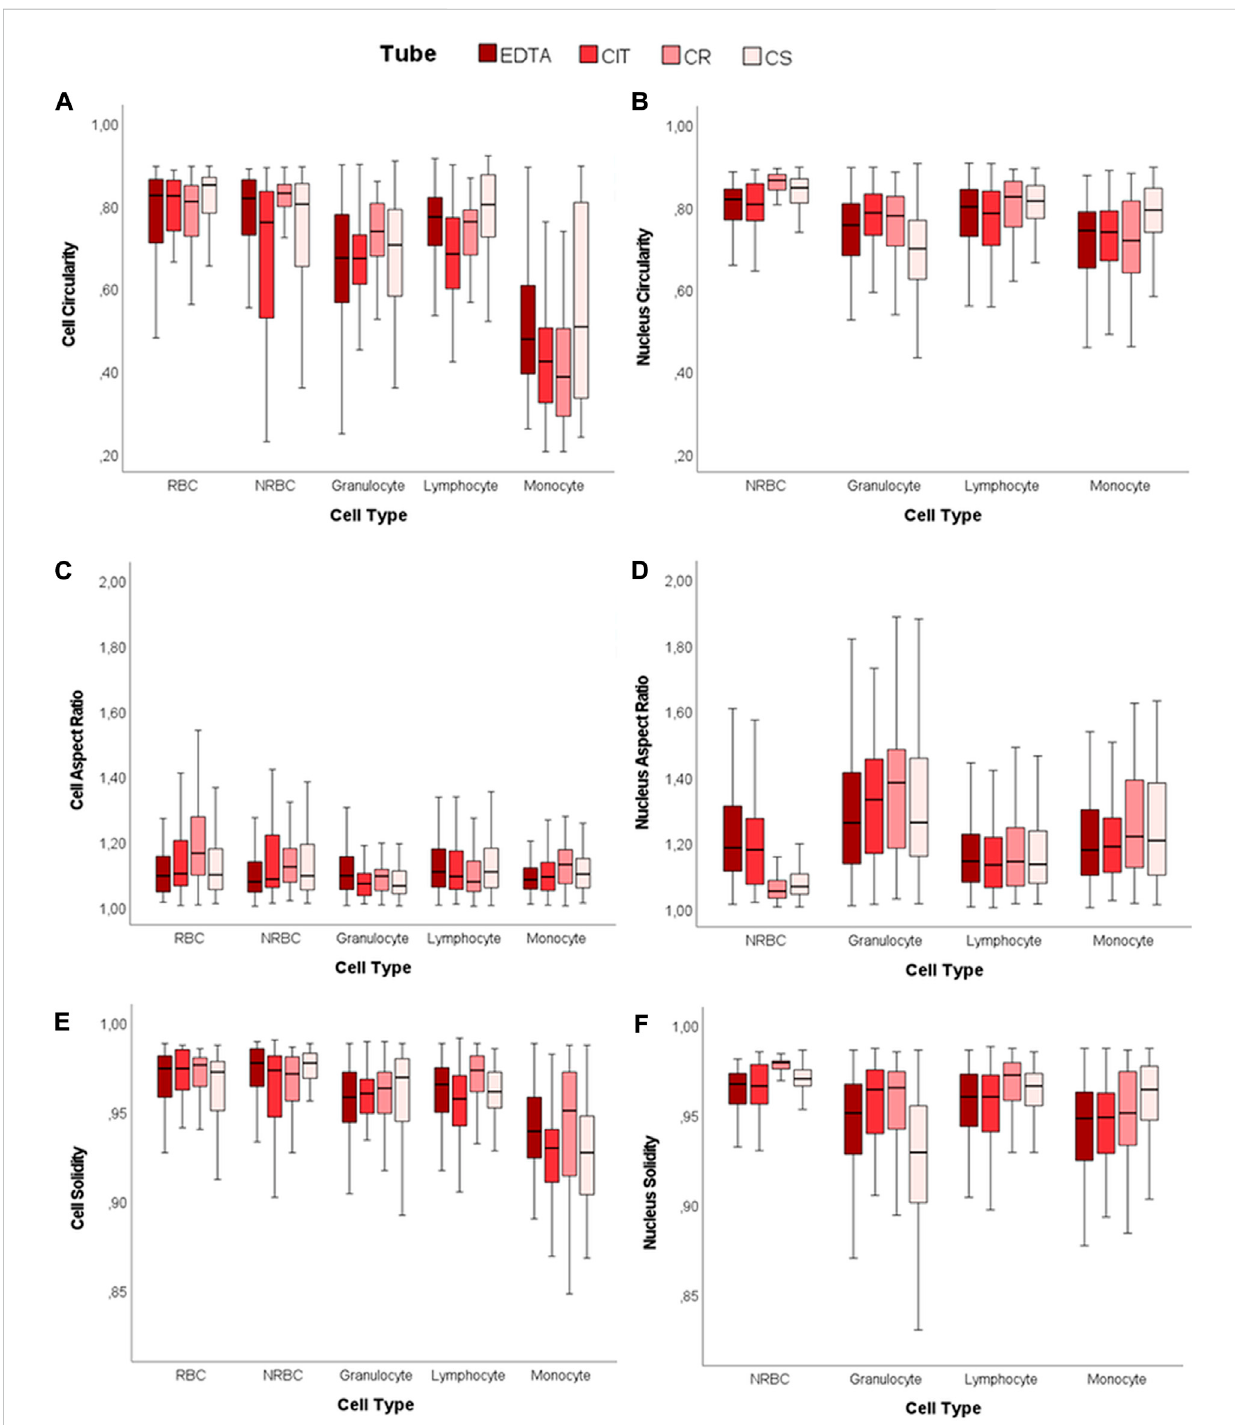
FIGURE 4 2D shape descriptors. Boxplots of cell and nucleus circularity, aspect ratio, and solidity. (A) Cell Circularity, (B) Nucleus Circularity, (C) Cell Aspect Ratio, (D) Nucleus Aspect Ratio, (E) Cell Solidity, and (F) Nucleus Solidity.